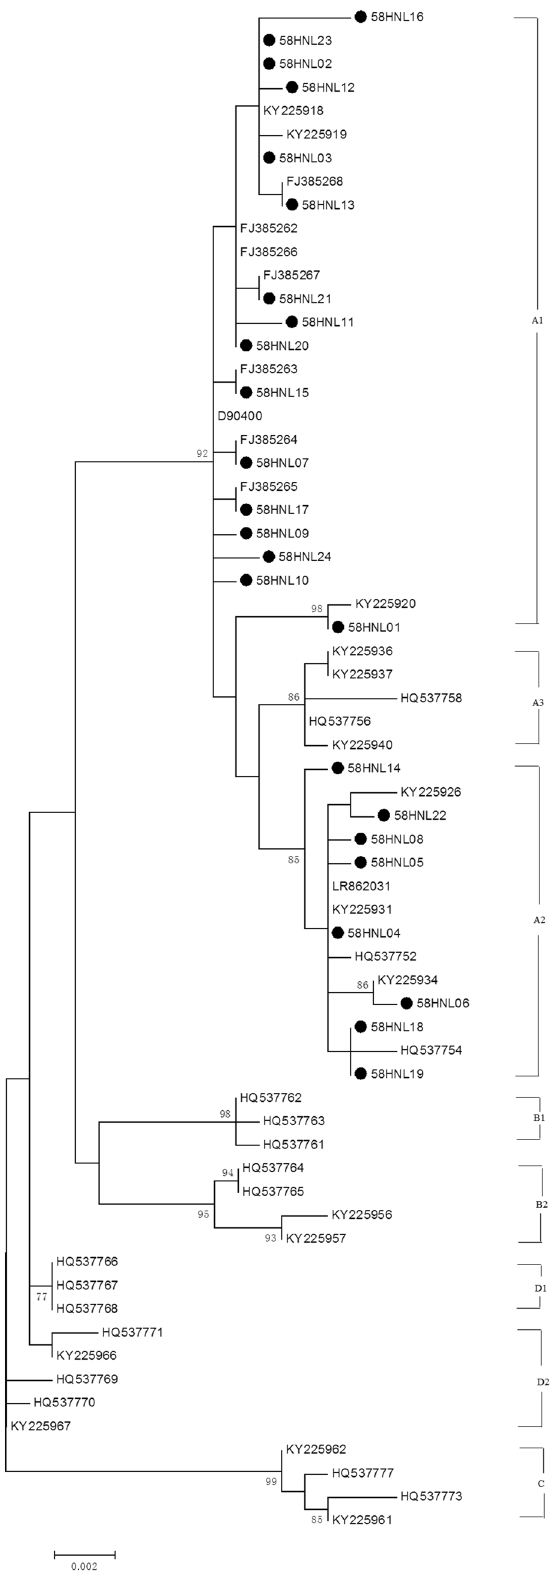
Figure 3. Phylogenetic tree generated using nucleotide sequences of the HPV58 L1 gene. Study sequences are labeled in dots, others without dots are reference strain, including: A1 (D90400, KY225918, KY225919, FJ385262-FJ385268), A2 (KY225926, KY225931, KY225934, HQ537752), A3 (KY225936, KY225937, KY225940, HQ537756, HQ537758), B1 (HQ537761-HQ537763), B2 (HQ537764, HQ537765, KY225956, KY225957), C (KY225961, KY225962, HQ537773, HQ537777), D1 (HQ537766-HQ537768) and D2 (KY225966, KY225967, HQ537768-HQ537770). Phylogenetic trees were constructed by the Maximum Likelihood method by MEGA 6.0 package. Only bootstrap values above 70% are displayed in the